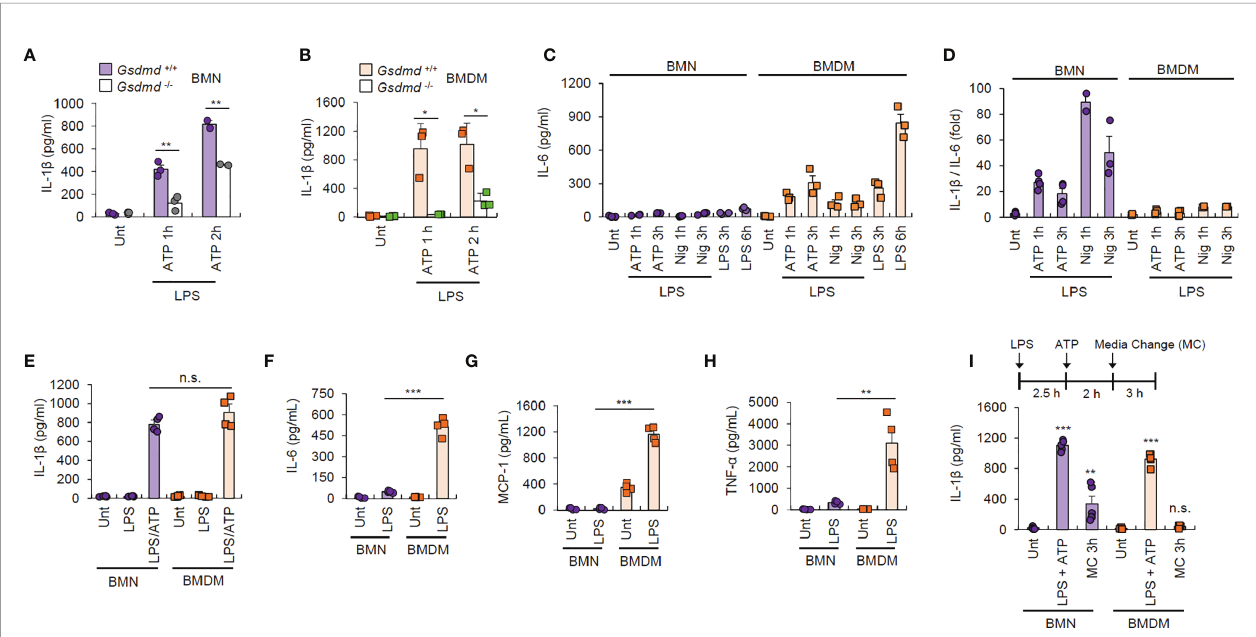
FIGURE 5 | Neutrophils exhibit unique IL-1 b -oriented cytokine production. (A, B) Quanti fi cation of IL-1 b in the culture supernatant of Gsdmd +/+ or Gsdmd -/- mouse BMNs (A) or BMDMs (B) treated with LPS (0.25 m g/mL, 2.5 h) followed by ATP (2.5mM, 1 or 2 h) treatment ( n = 3). (C, D) Quanti fi cation of IL-6 (C) or the relative IL-1 b /IL-6 ratio (D) in the culture supernatant of mouse BMNs or BMDMs primed with LPS (0.25 m g/mL, 2.5 h), washed and treated with ATP (2.5mM) or nigericin (5 m M) for 1 or 3 h, or treated with LPS alone ( n = 3). (E) Quanti fi cation of IL-1 b in the culture supernatant of mouse BMNs or BMDMs primed with LPS (0.25 m g/mL, 2.5 h) followed by ATP (2.5mM, 1 h) treatment ( n = 4). (F – H) Quanti fi cation of IL-6 (F) , MCP-1 (G) , and TNF- a (H) in the culture supernatant of mouse BMNs or BMDMs treated with LPS (0.25 m g/mL, 3 h) ( n = 4). (I) Quanti fi cation of IL-1 b in the culture supernatant of mouse BMNs or BMDMs treated with LPS (0.25 m g/mL, 2.5 h) followed by ATP (2.5mM, 2 h) treatment, washed and incubated for 3 h in the presence of additional LPS and ATP ( n = 5). Culture supernatants (Sup) or cell lysates (Lys) were immunoblotted with the indicated antibodies. * P < 0.05, ** P < 0.01, *** P < 0.001, n.s. not signi fi